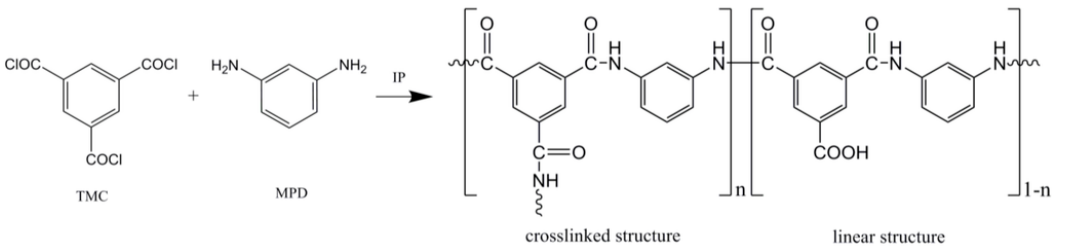
Figure 3. Interfacial polymerization (IP) between trimosyl trichloride (TMC) and 1,3- phenylenediamine (MPD).